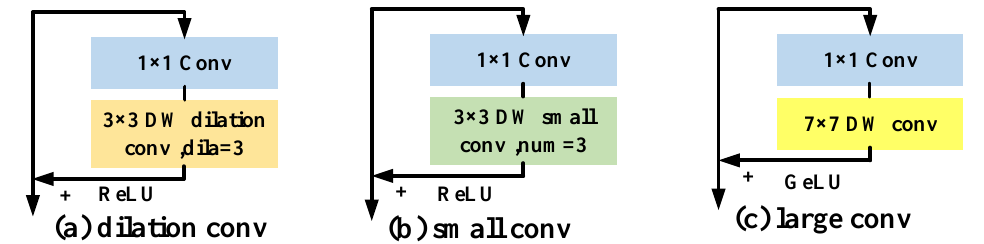
Figure 7. Different ways to expand the receptive field of CNN. DW conv means depth convolution. ReLU has a gradient of 0 for the majority of pixels in the region away from the Gaussian kernel, as seen in Equation (1) or Figure 4, which prevents the corresponding gradients from updating and converging to the vicinity of the aircraft keypoints. According to Equation (9), GeLU causes the gradient to be continuously close to 0, which aids in the heatmap’s convergence toward the location of the aircraft